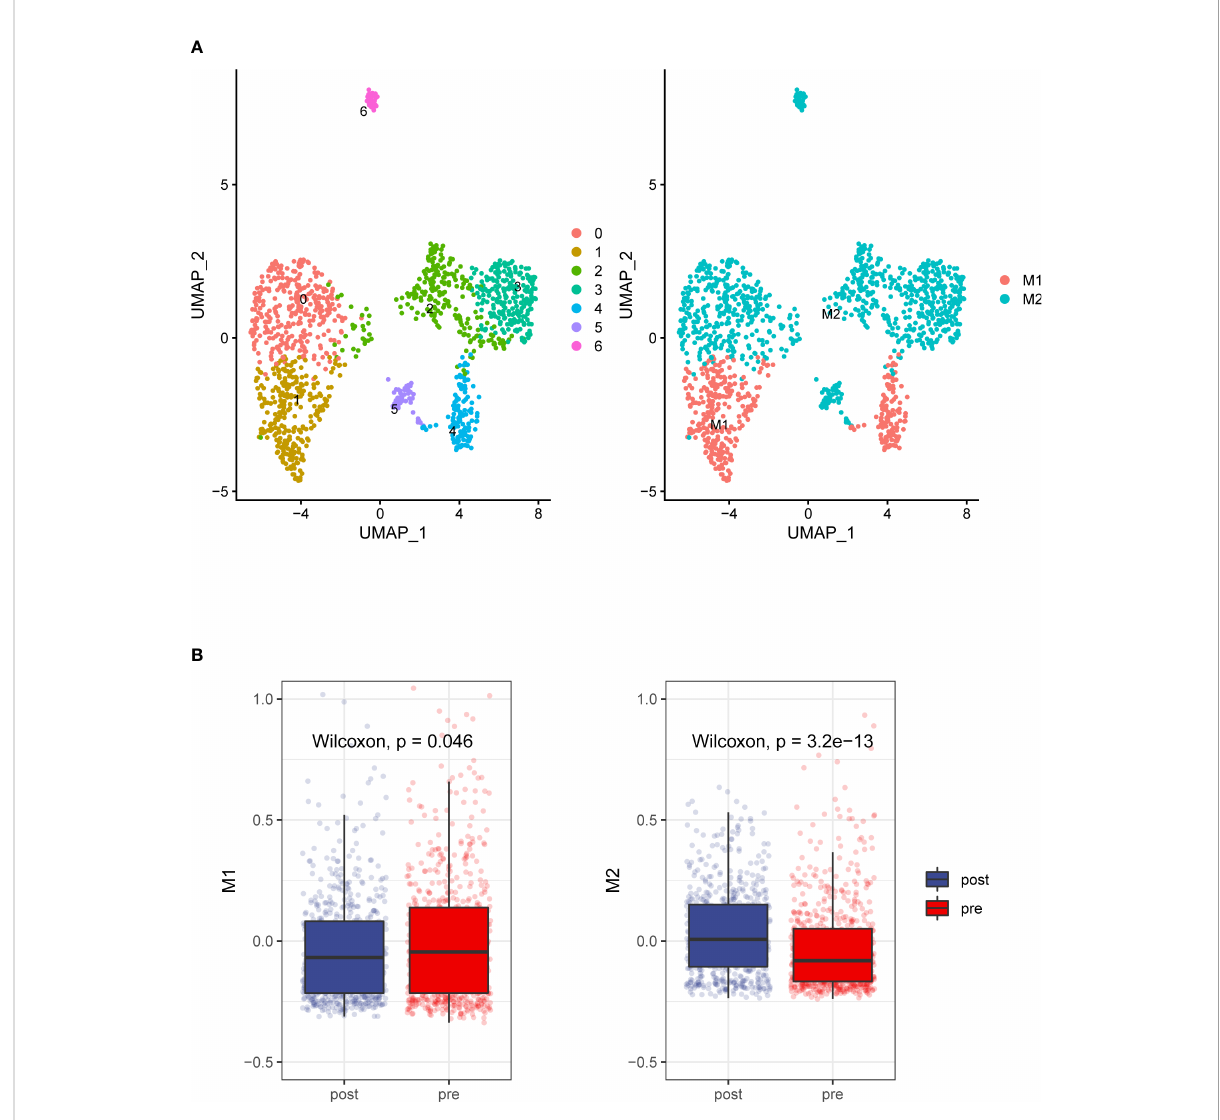
FIGURE 4 Detailed characterization of macrophage cells. (A) UMAP plot showing 7 clusters of macrophage cells. According to gene signature of M1 and M2, Macrophages grouped into two categories (B) . Compare to the prostate tumors tissue without ADT, prostate cancer tissue with ADT shows more M2 signatures and less M1